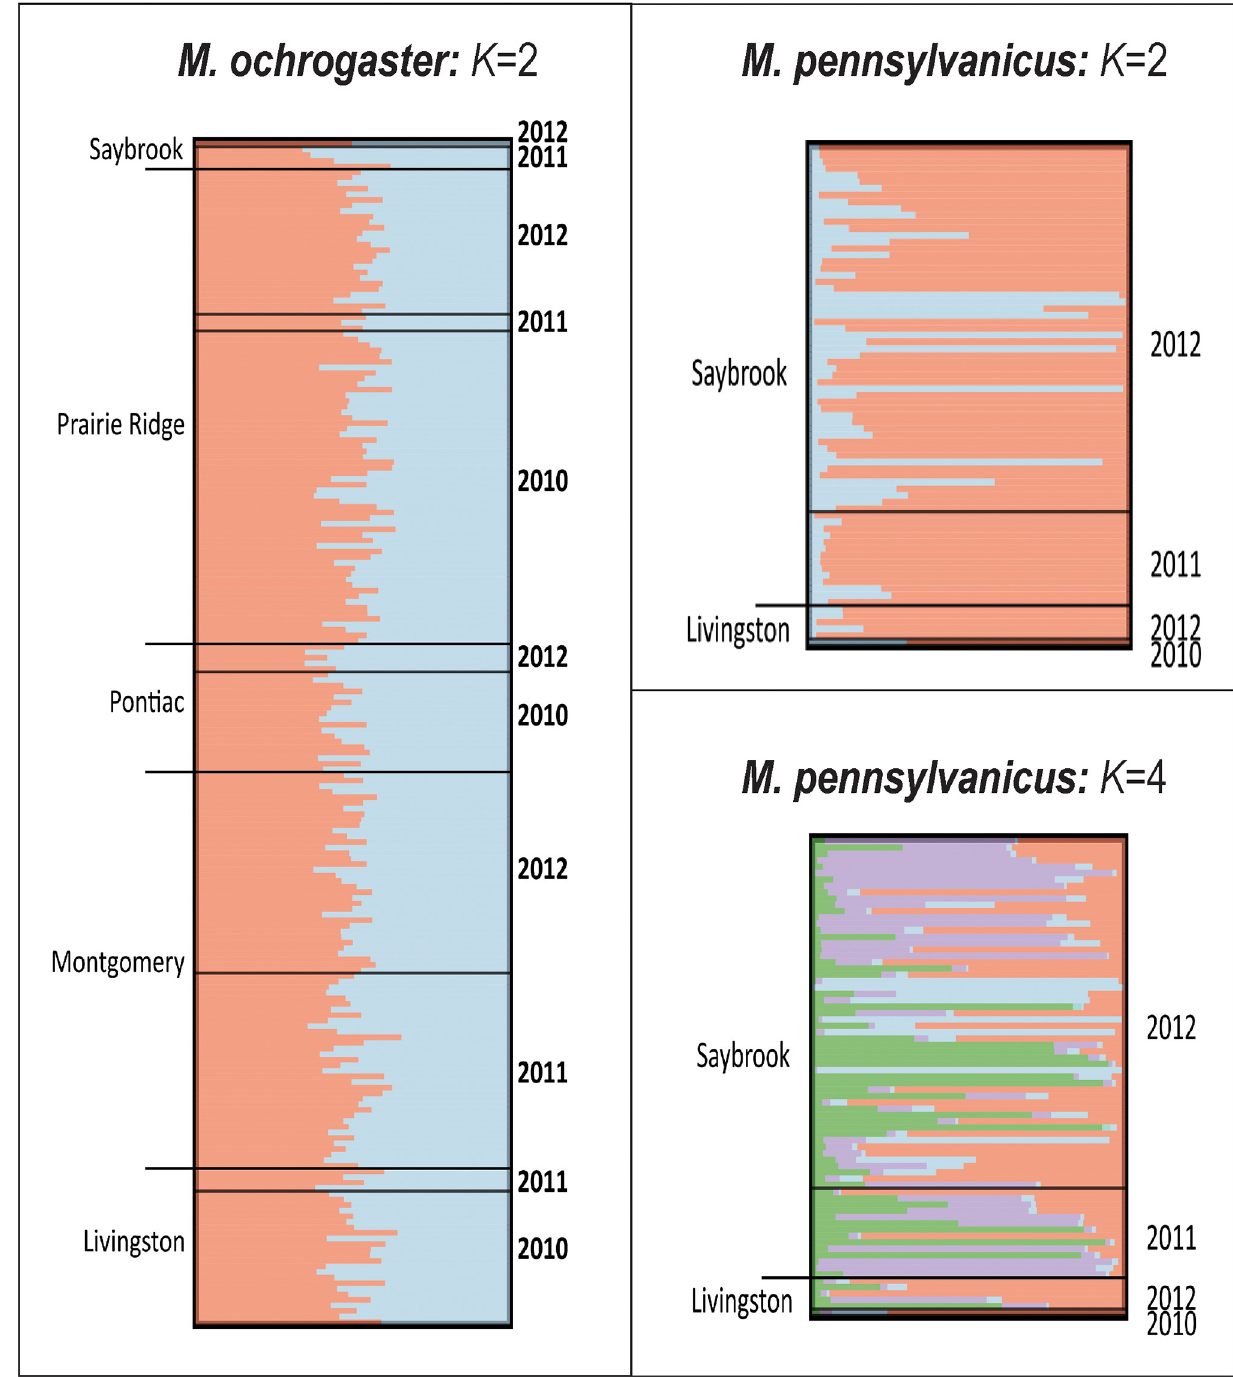
Fig 3. Spatial and temporal genetic patterns in M . ochrogaster and M . pennsylvanicus .